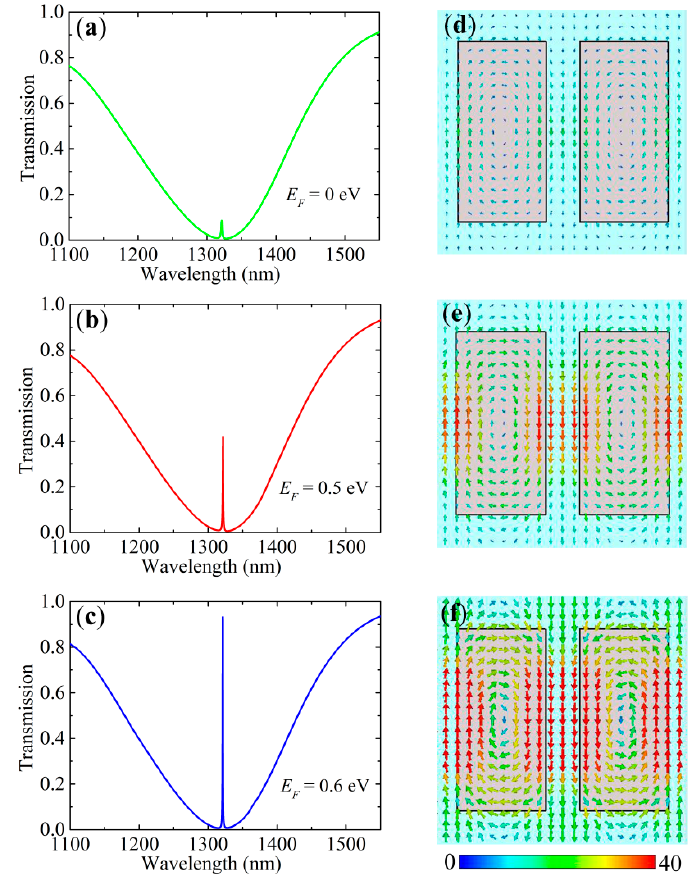
Figure 6. ( a – c ) Transmission spectra and ( d – f ) corresponding electric field distributions at the toroidal dipole resonance of the graphene-loaded all-dielectric metasurface for E F = 0 eV, 0.5 eV and 0.6 eV, respectively.